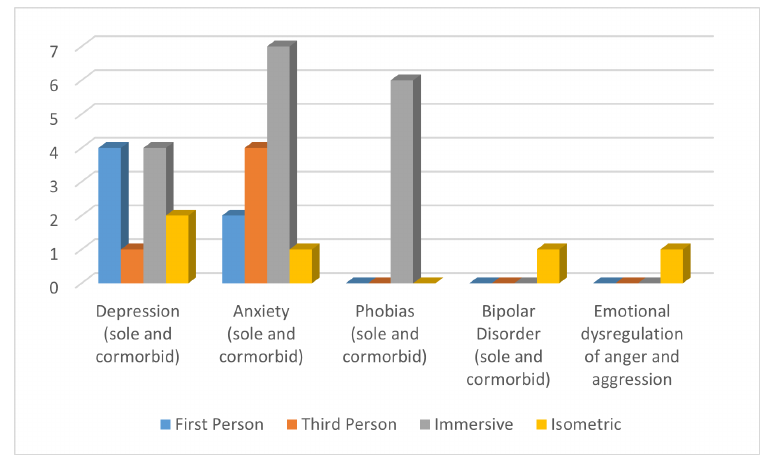
Figure 4. Player perspectives of the games used for each affective disorder.